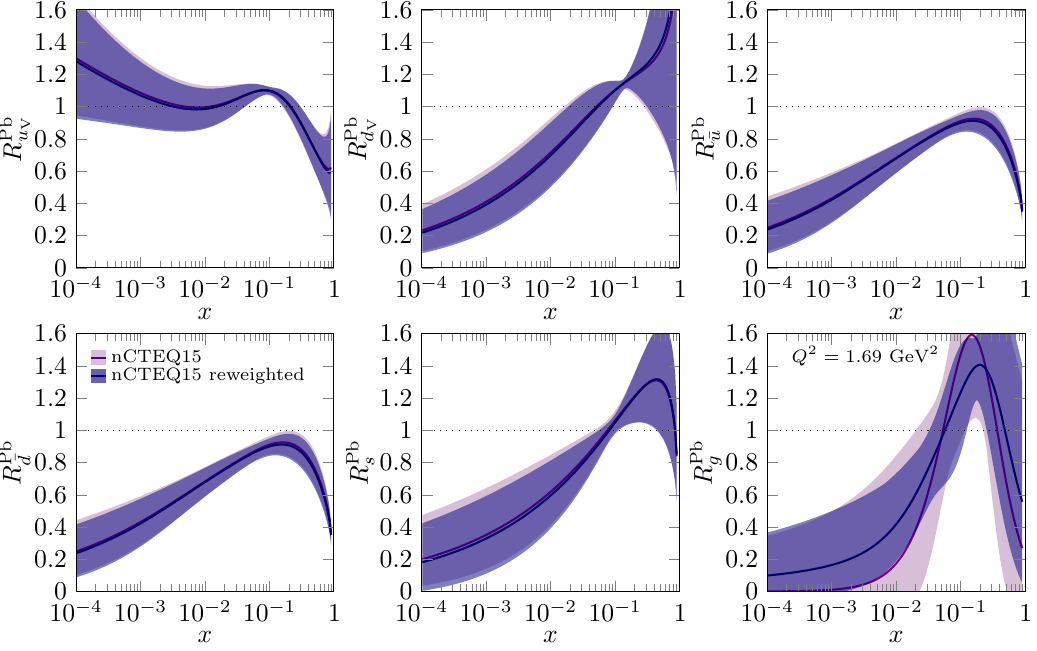
Figure 10 . The nCTEQ15 nuclear modi(cid:12)cations for bound-proton PDFs in Pb nucleus before (purple) and after (blue) reweighting with the LHCb data. The scale is Q 2 = 1 : 69 GeV 2